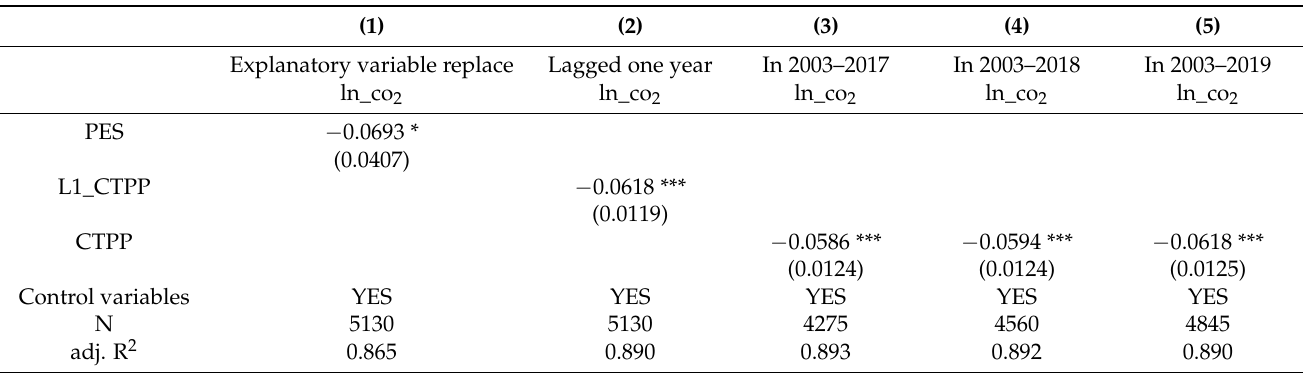
Table 6. Regression results of variable replacement lag phase and